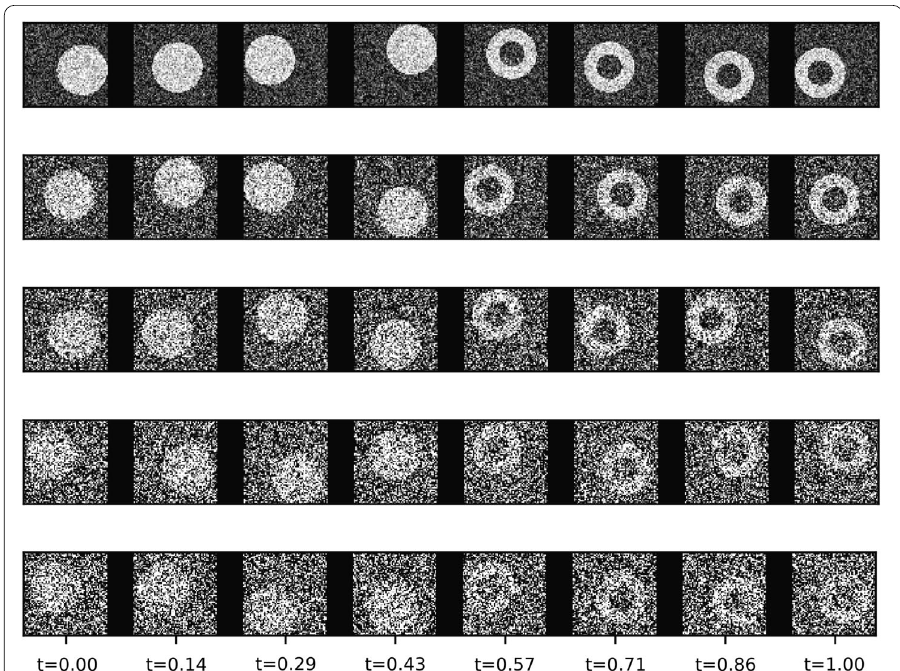
Figure 2 Example time series of synthetic images that change at t 0 = 0.5 when a solid circle changes to a hollow circle. From top to bottom, each row shows images with an increasing noise level σ = 0.2,0.4,0.6,0.8 and 1.0